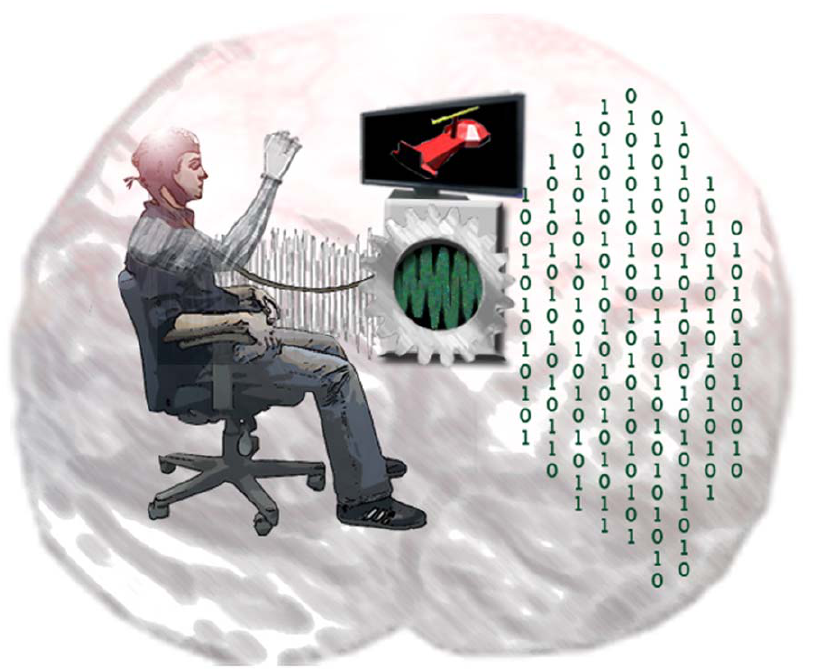
Figure 1. A diagrammatic representation of the presented BCI system. Using specifically trained motor imaginations learned in single dimensional cursor tasks, subjects control the three-dimensional movement of a virtual helicopter. Raw EEG is temporally and spatially filtered to produce individualized control signal components. These components are weighted and digitized in a subject specific manner and output to influence control in the virtual world.